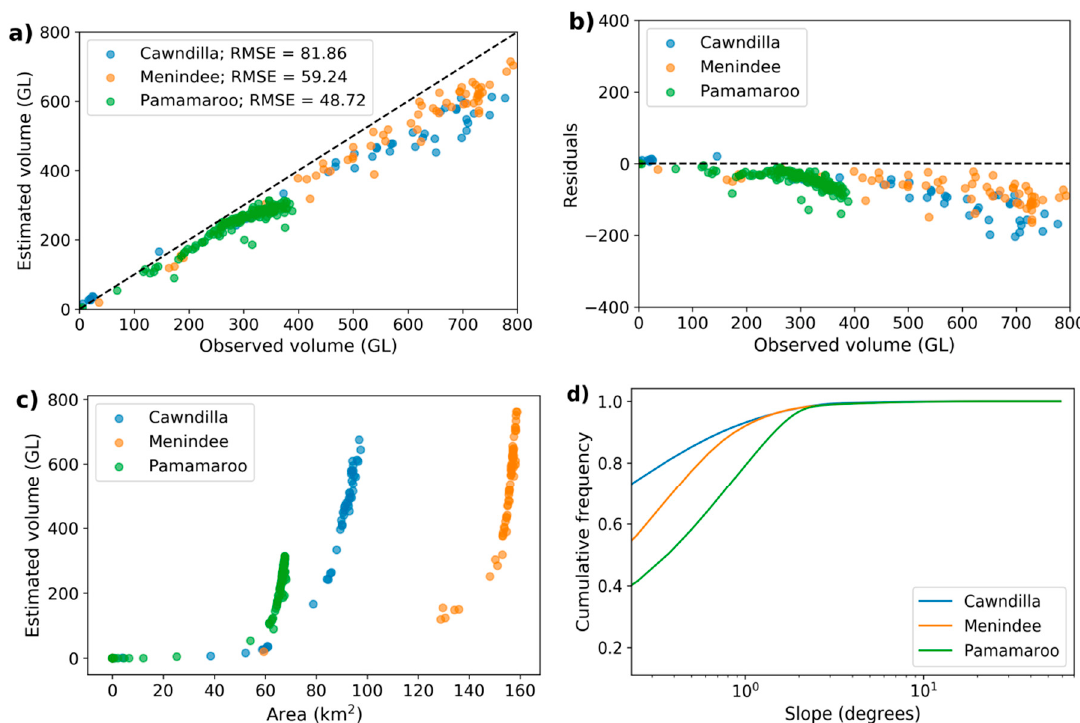
Figure 9. Water volume estimates ( a ), residuals ( b ) and area–volume relationship ( c ) obtained using the inverse distance weighting interpolation methodology on the Cawndilla, Menindee, and Pamamaroo lakes. The cumulative frequency of slopes in the reservoirs is also presented ( d ).